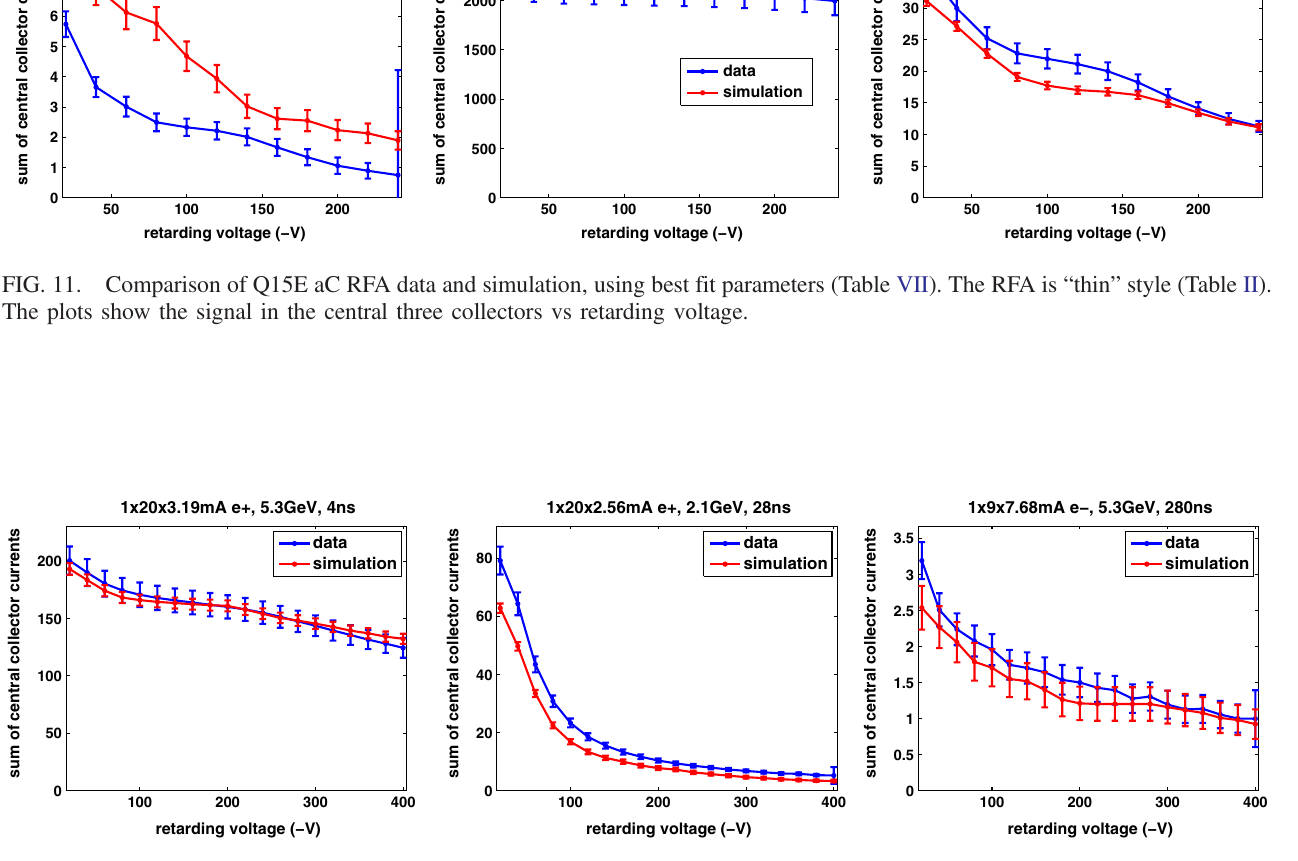
FIG. 12. Comparison of Q15W DLC RFA data and simulation, using best fit parameters (Table VII). The RFA is “ Insertable II ” style (Table II). The plots show the signal in the central three collectors vs retarding voltage.